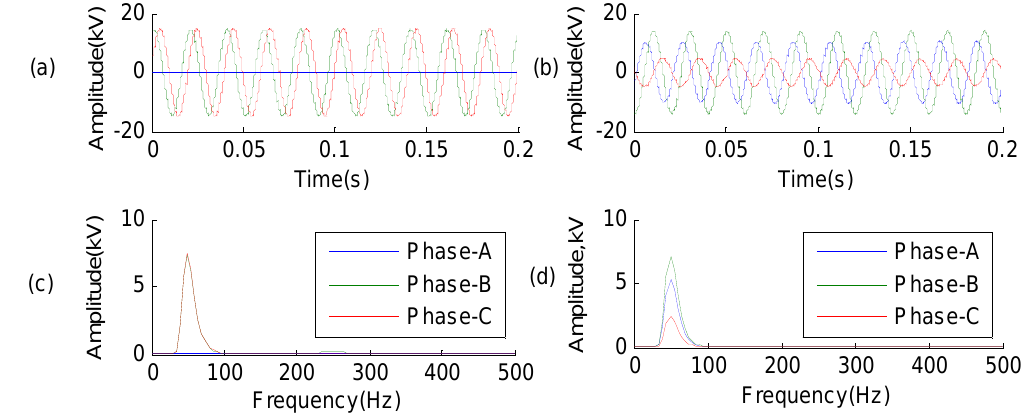
Figure 5. ( a ) Single phase-to-ground voltage; ( b ) Fundamental ferroresonance; ( c ) Mean amplitude curve of single phase-to-ground voltage; ( d ) Mean amplitude curve of fundamental